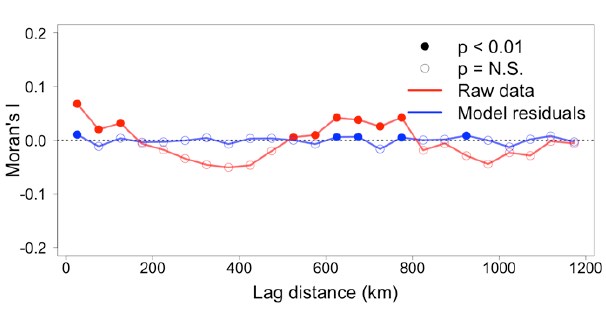
Fig. 4 . Patterns of spatial autocorrelation (Moran’s I) for raw richness data (red) and residuals of top model including environmental and observational factors (blue). Solid circles represent significant correlations (p < 0.01, Bonferroni corrected for number of distance classes). Dashed line represents zero